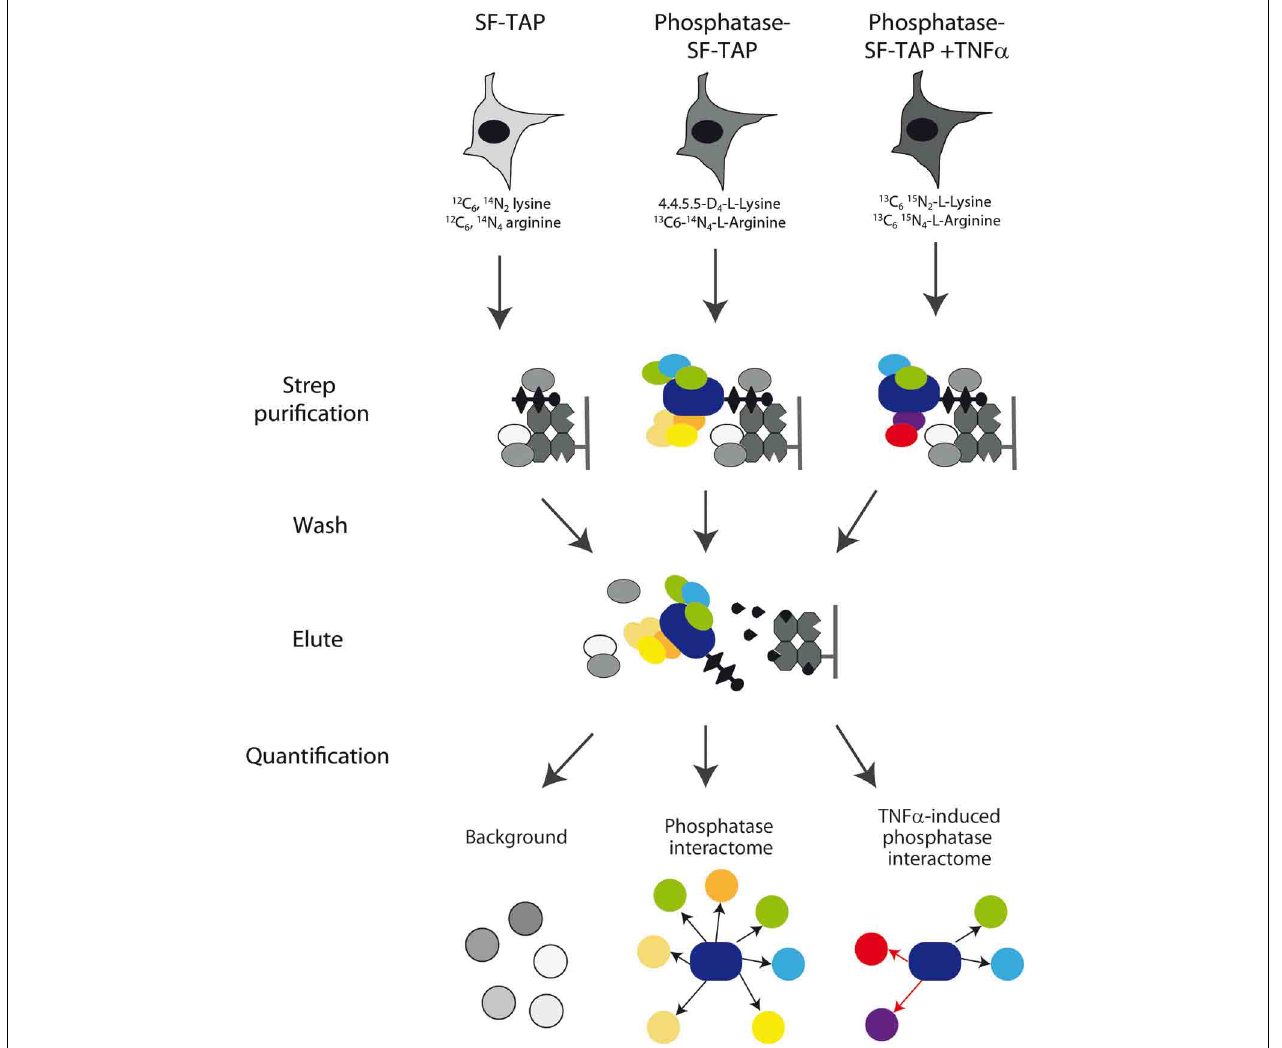
FIGURE 2 | Experimental strategy. Schematic overview of the experimental strategy applied to analyze the phosphatase interactome. Phosphatase transfected HeLa cells with or without TNF α were grown in media containing heavy isotope labeled lysine and arginine amino acids, while the control cells were grown in a medium containing natural amino acids. After lysis,